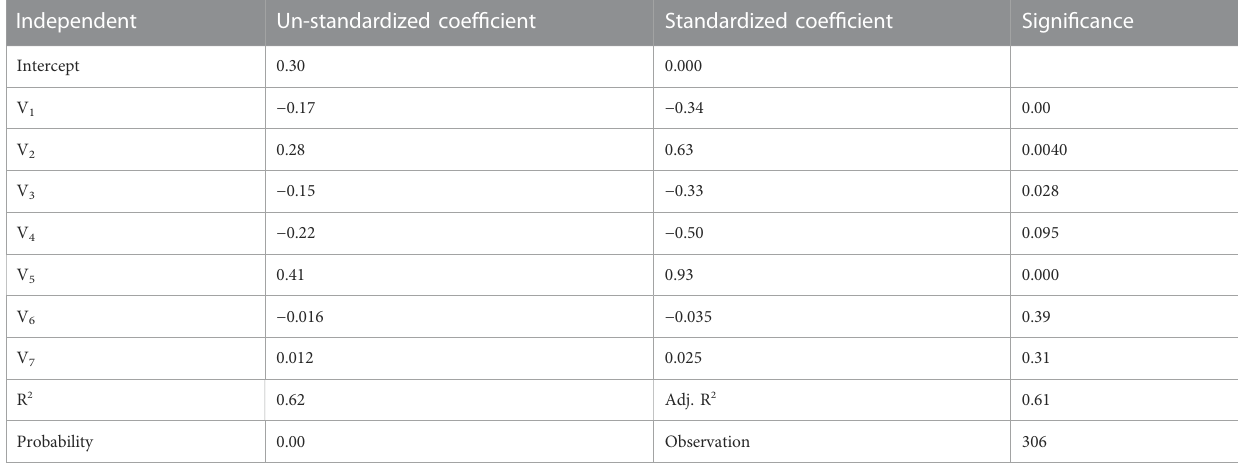
TABLE 3 Driving factors investigated by QAP regression analysis.